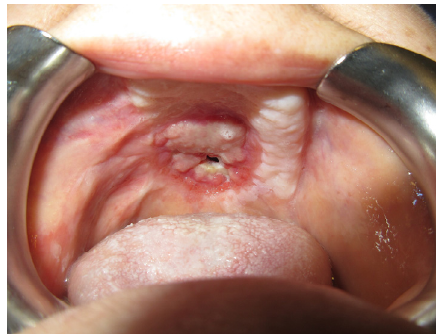
Figure 16. Before NSPF.